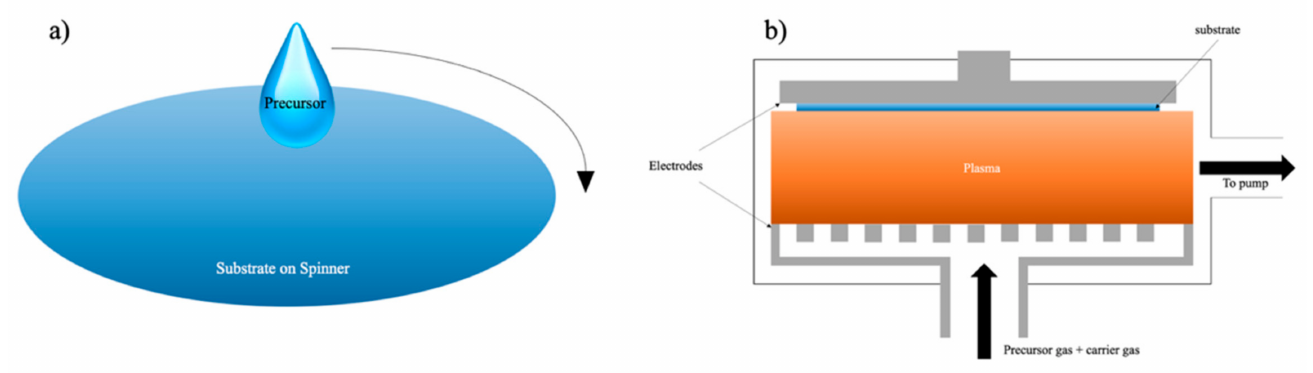
Figure 7. Schematic demonstration of spin-on deposition ( a ) and the PECVD method ( b